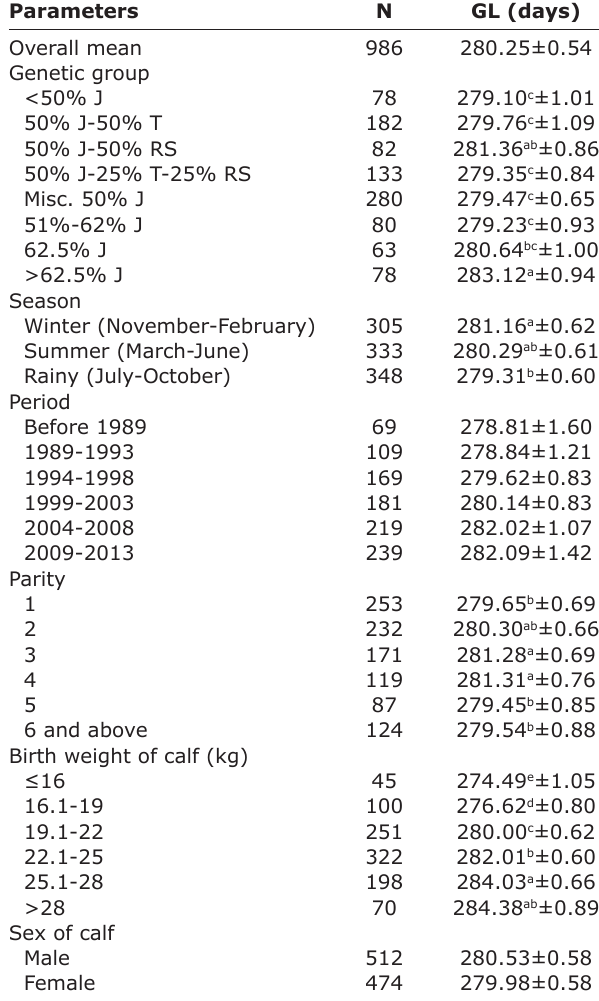
Table-3: Least squares means (±SE) for GL of Jersey crossbred cattle.